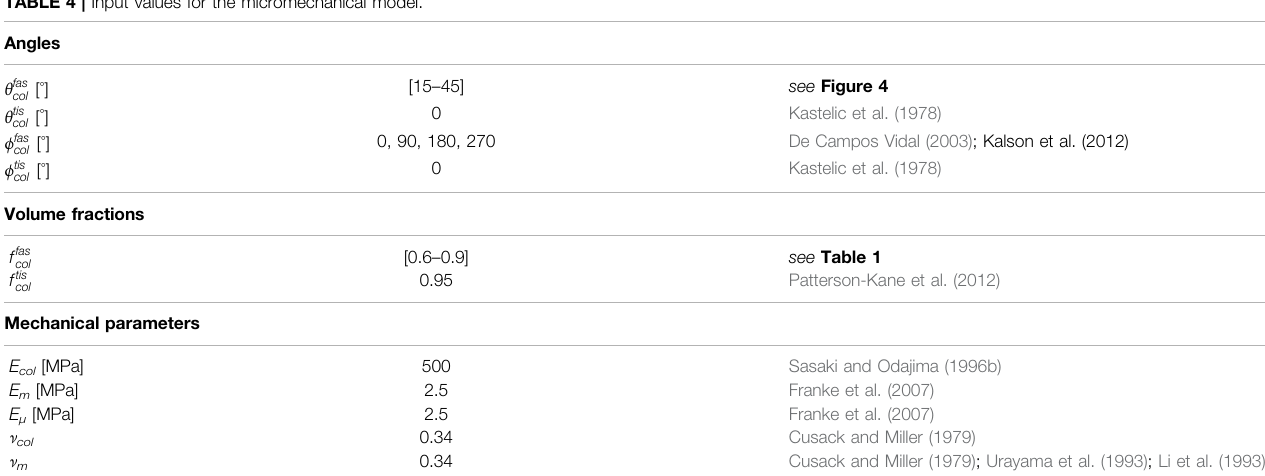
TABLE 4 | Input values for the micromechanical